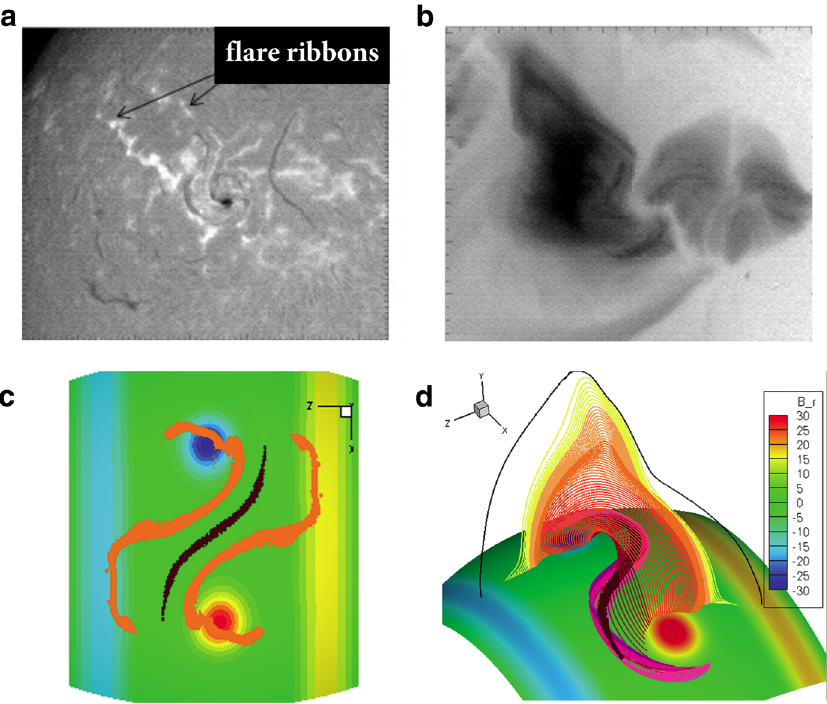
Fig. 11 Partially-erupting sigmoids/filaments. a BBSO H α observations of flare ribbons surrounding a filament unaffected by the eruption and b Yohkoh SXT (inverse color scale) observations of a sigmoid with overlying cusped field lines. c Footpoints of reconnected field lines during partial flux rope eruption, and d field lines surviving the eruption, including cusped field lines (yellow/orange) overlying the remains of a BPSS (purple) and dipped field (brown). Note that the Yohkoh/BBSO observations of the eruption shown here are of the same region, but two days prior to the non-erupting sigmoid shown in Fig. 10. Images reproduced with permission from [top] Gibson et al. (2002), copyright by AAS, and [bottom] from Tripathi et al. (2009), copyright by